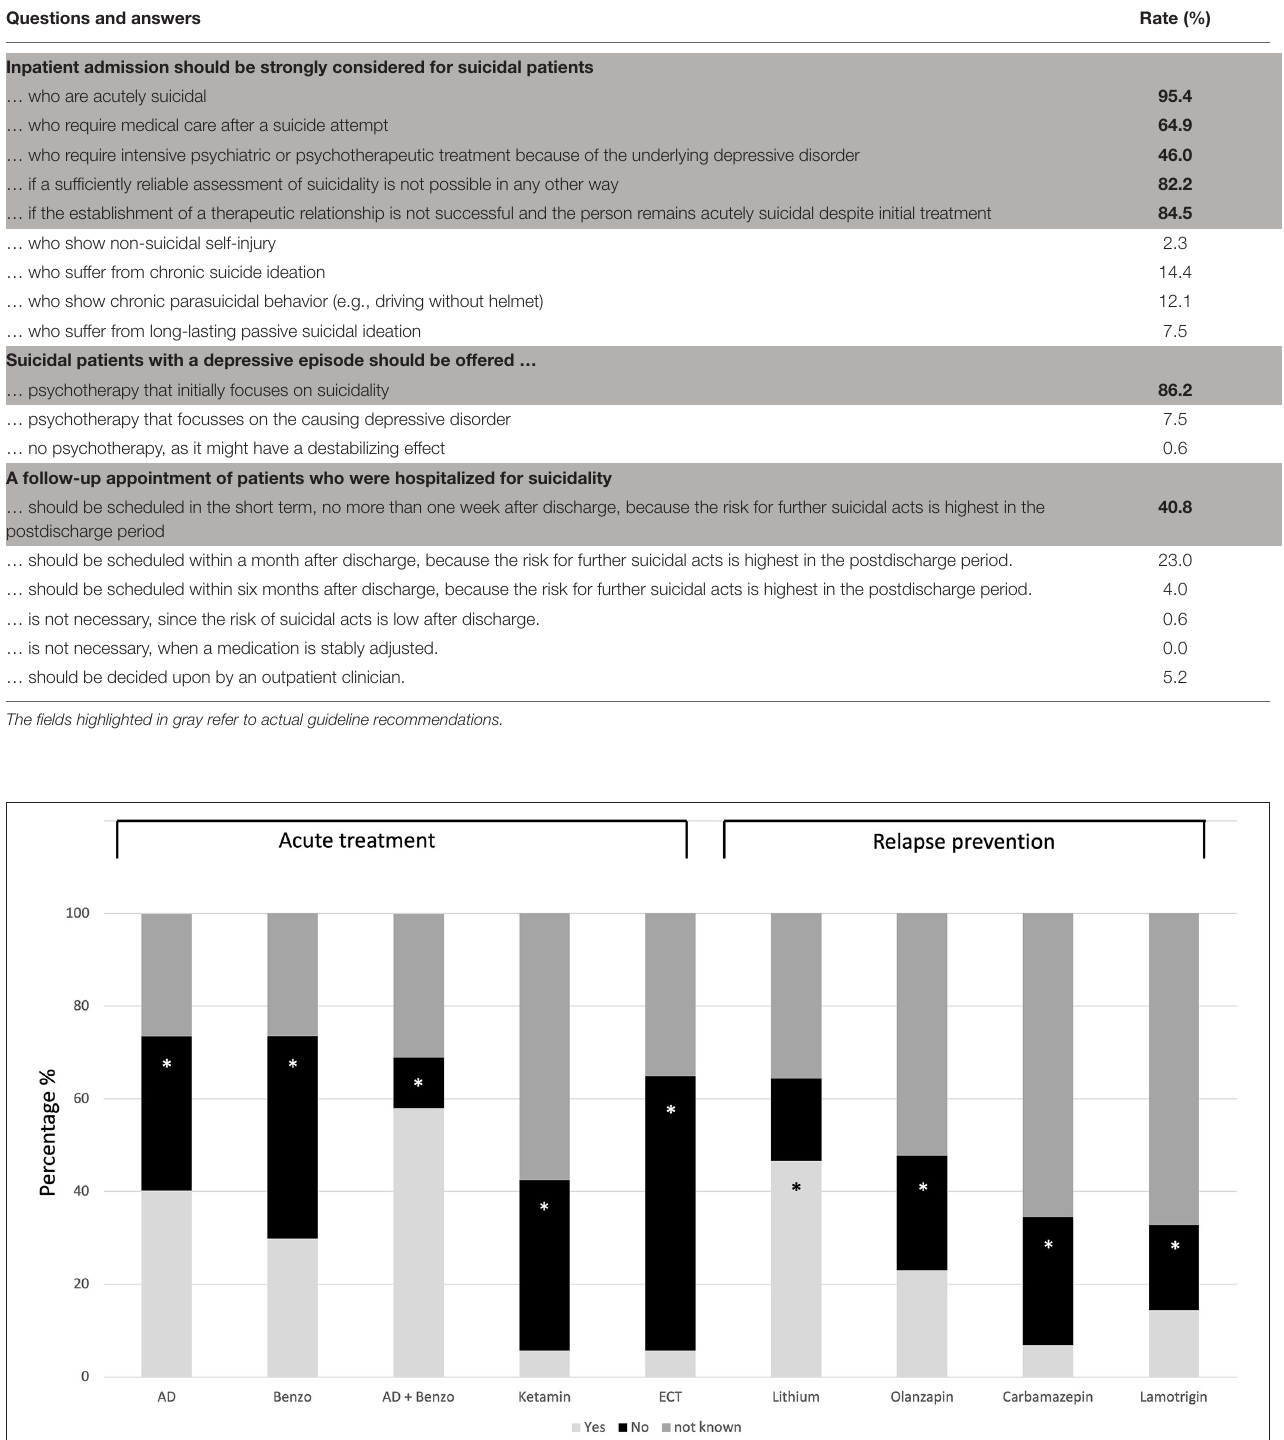
Frontiers in Psychiatry |